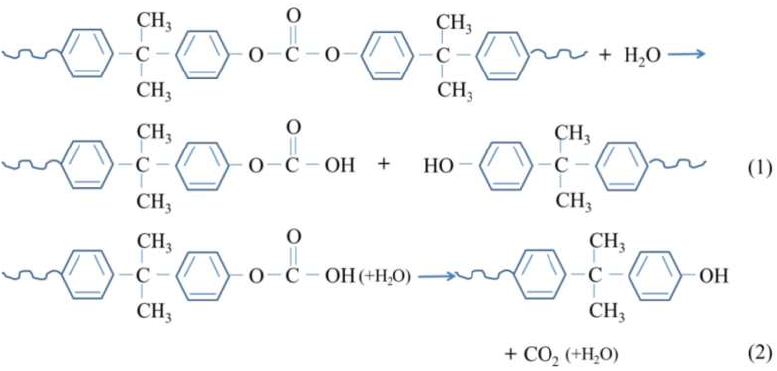
Figure 5. Schematic diagram of hydrolysis mechanism for PC.